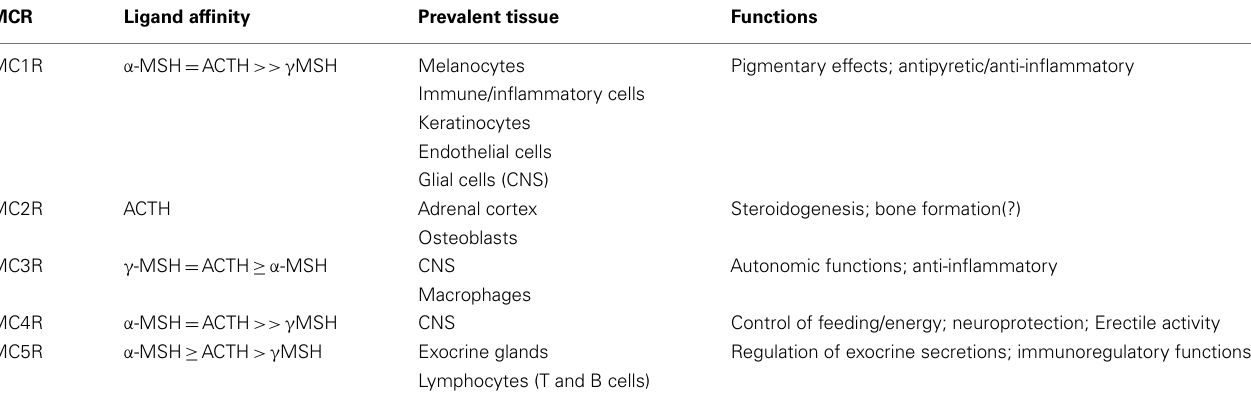
Table 1 | MCR distribution, affinity, and